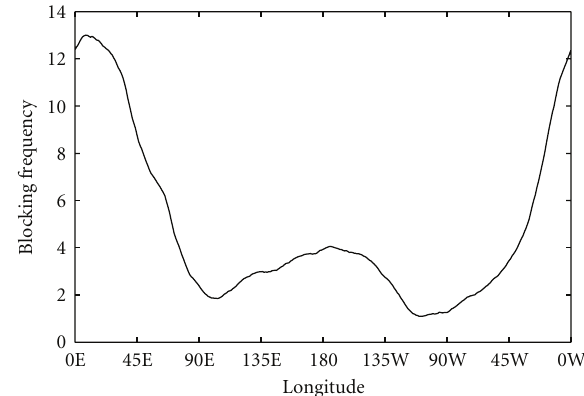
Figure 9: Reduction in zonal mean blocking frequency with increasing persistence filter (with extent filter width 21 . 375 ◦ , without quantile filters).